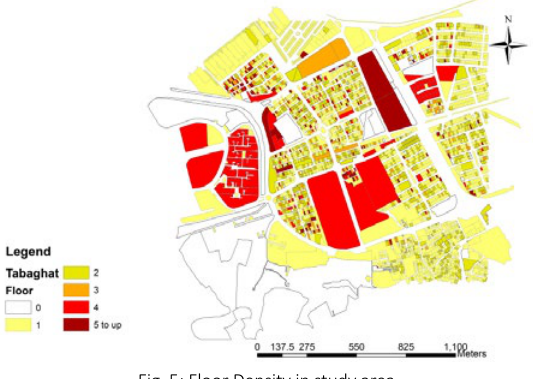
Fig. 6: Accessibility and Physical Quality in study area